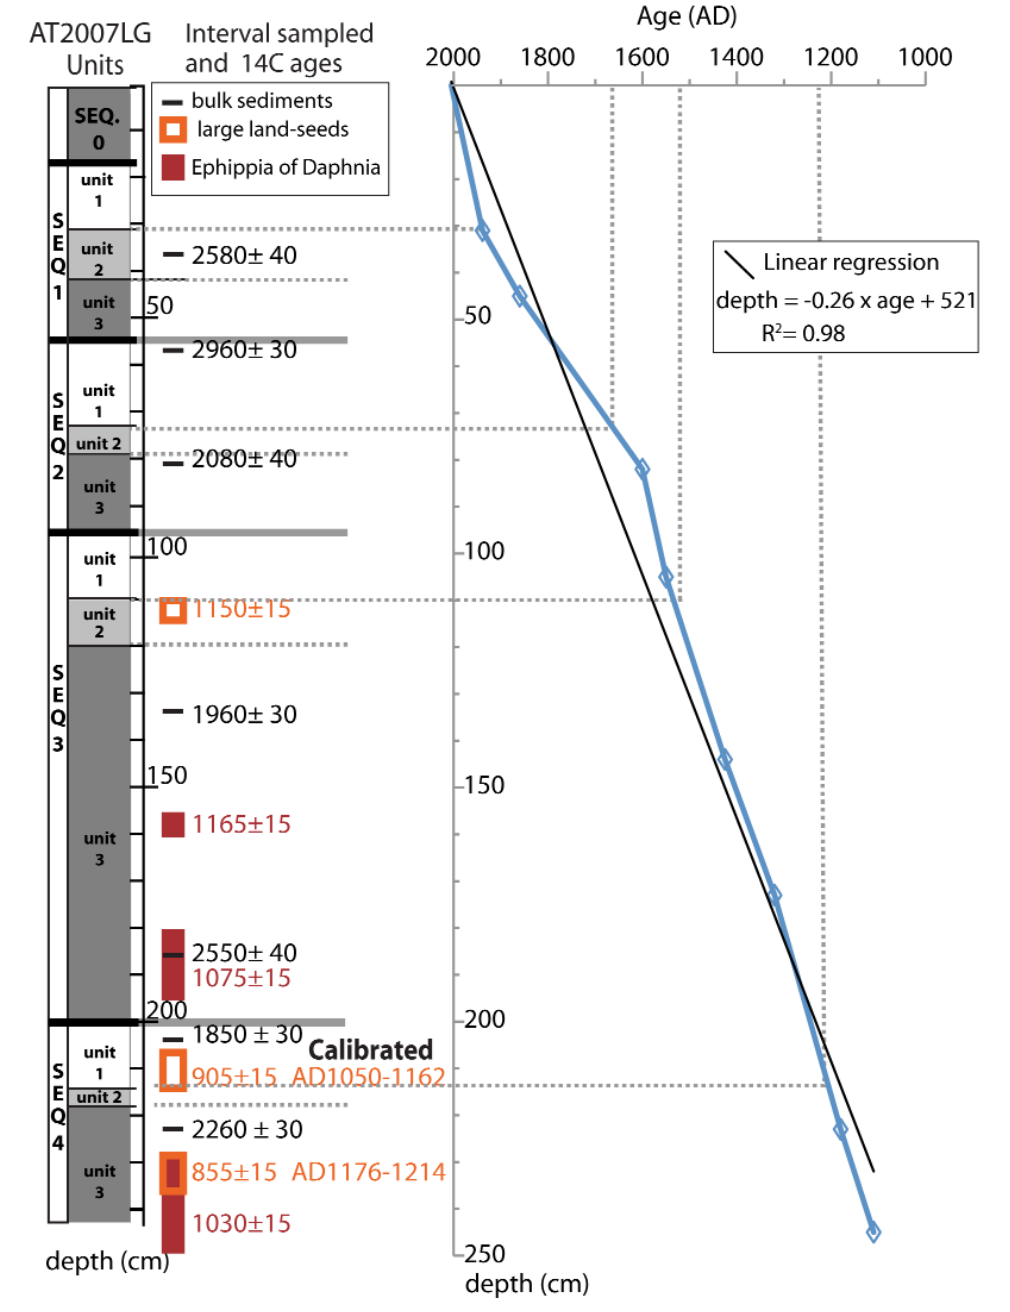
Figure 11. Age model of the AT2007 core based on the correlation in Figure 9. Left: stratigaphic division of core AT2007LG into sequences and units; right: intervals sampled for 14 C dating and obtained ages; far right: inferred sedimentation rates in A ş a ğ ıtepecik Lake. Ages for event horizons at the base of the units 1 can be inferred in this